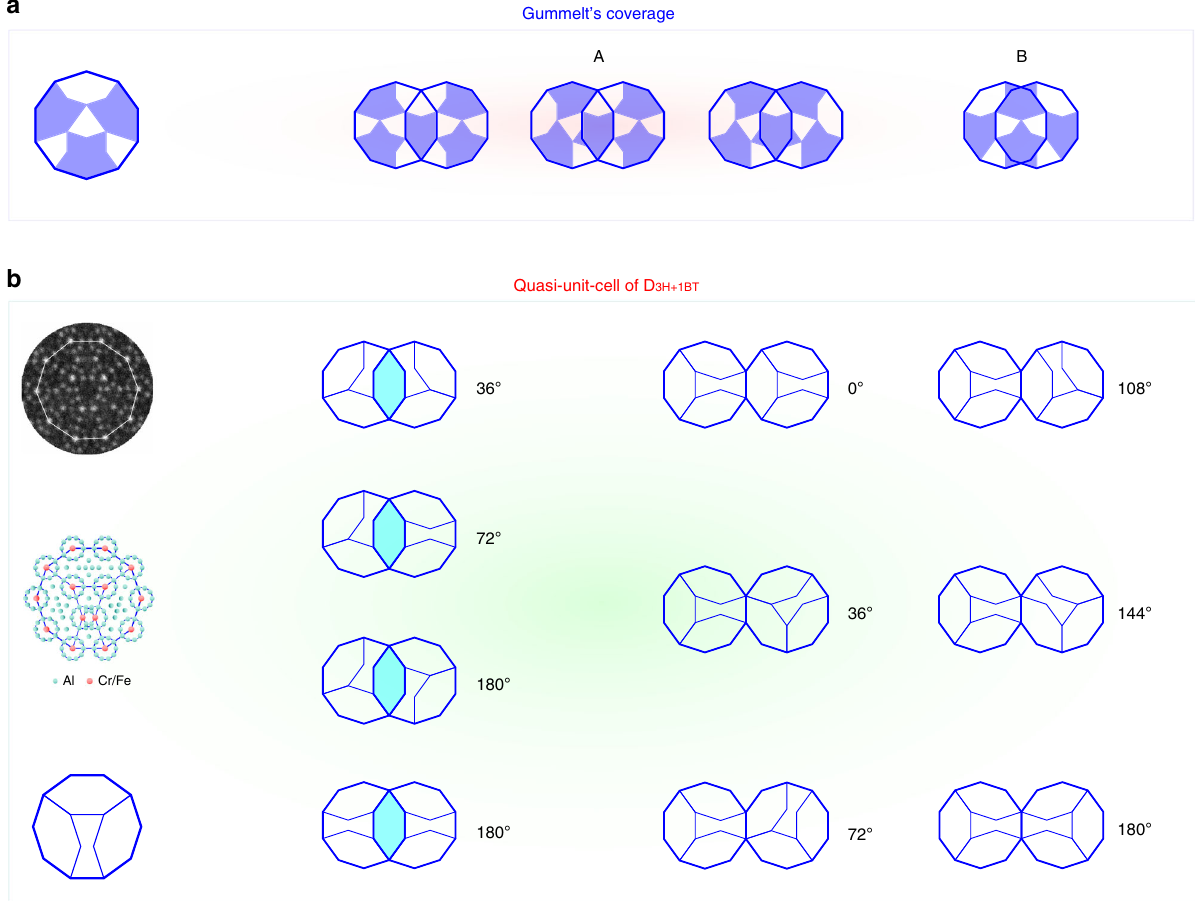
Fig. 3 Comparison of overlaps of Gummelt decagons and of the experimentally observed Lück decagons. a Allowed arrangements of Gummelt decagons. Middle and right: A- and B-type overlaps with strict matching rules (see ref. 9 for details). b Quasi-unit-cell of D 3H + 1BT in this paper. Left column: experimental image, projected structural model (Red atoms: Cr/Fe; blue atoms: Al) and schematic diagram of the quasi-unit-cell D 3H + 1BT ( ≈ 2.0 nm diameter). Middle and right: typical connections of Lück decagons by overlapping H tiles or by sharing an edge. They lead to two different distances of the decagon centers: S = 1.18 nm, and L = τ S = 1.91 nm. Their connections are relatively simple without strict matching rules. The observed orientations of adjacent decagons are shown